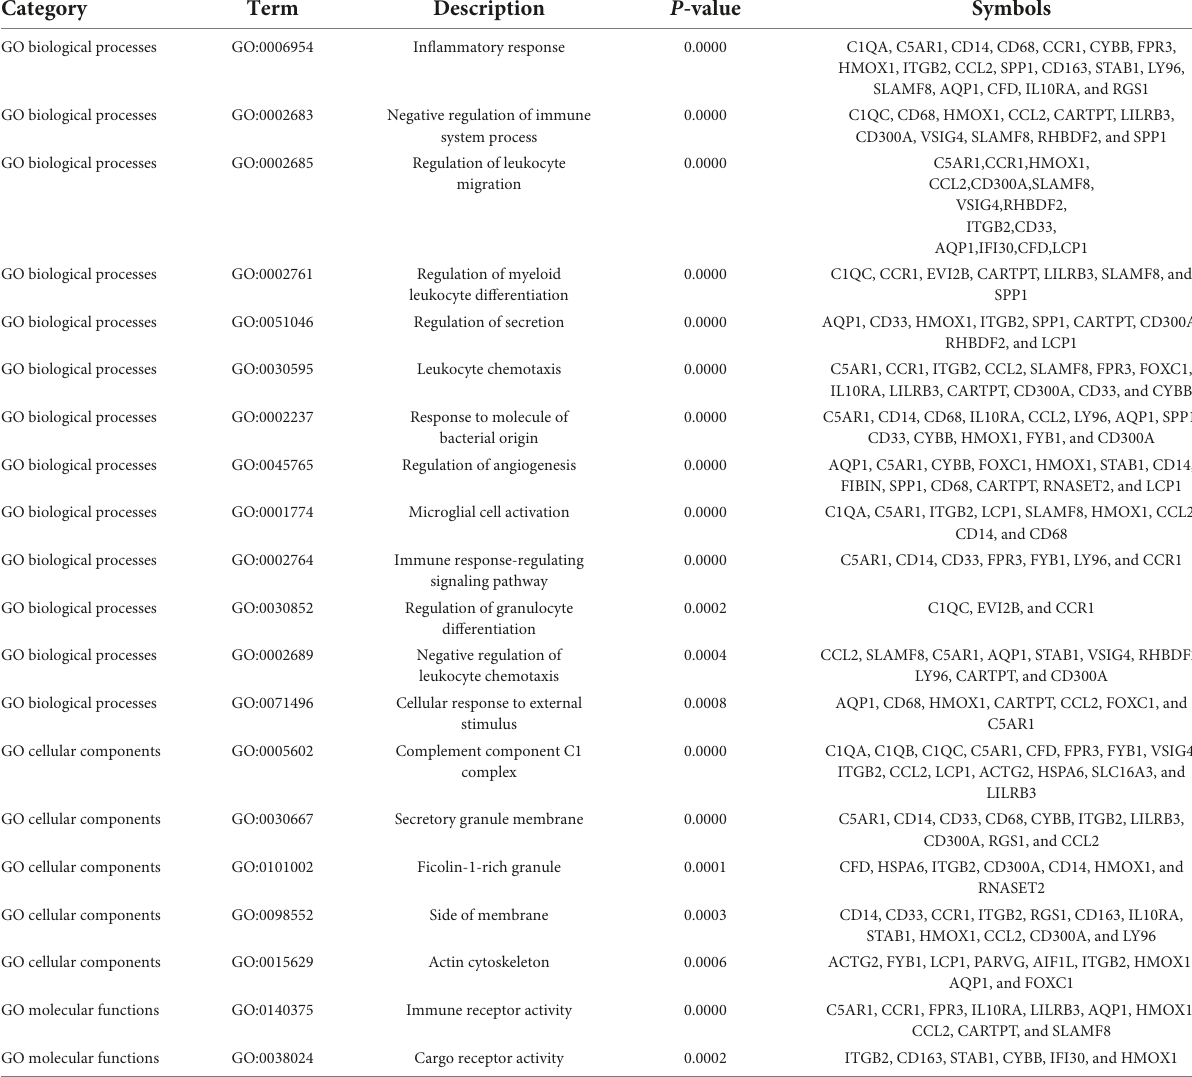
TABLE 2 Significantly enriched GO terms of the overlapping differentially expressed genes (DEGs) between vascular dementia (VaD) and carotid atherosclerotic plaques